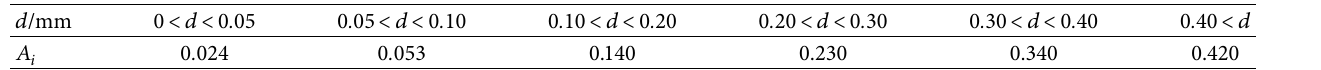
Table 2: Fracture width weight Ai Table.